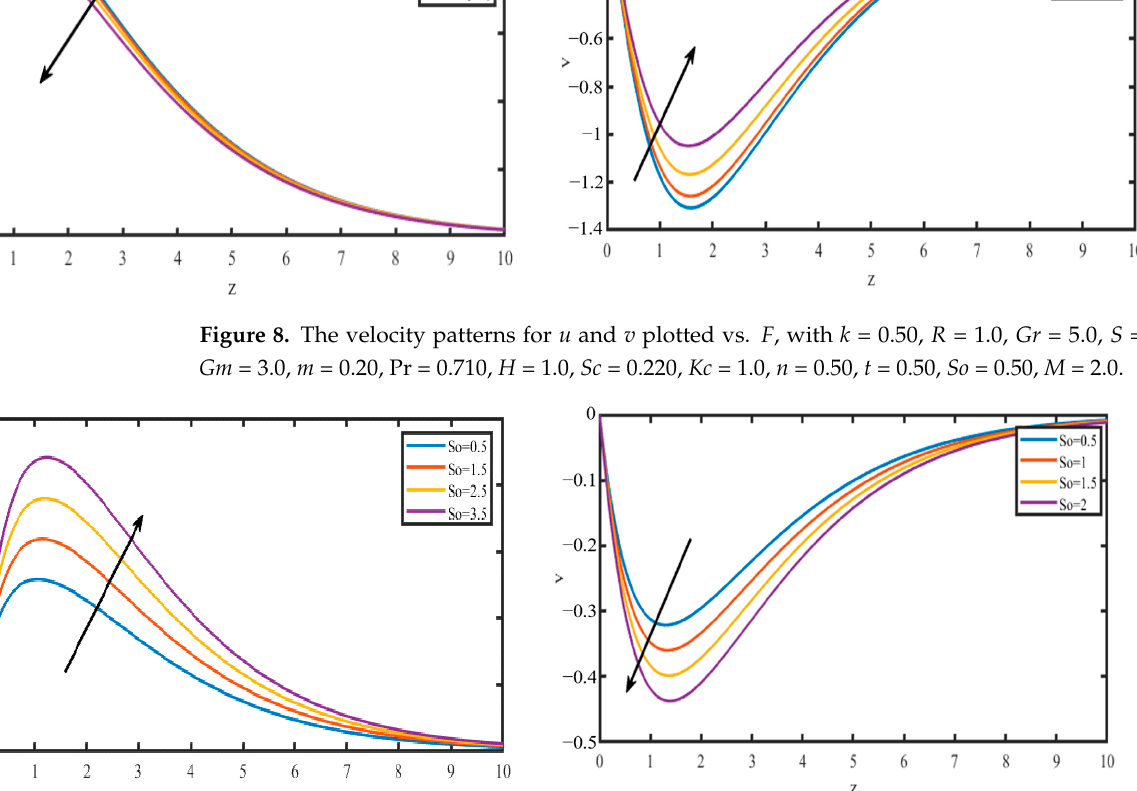
Figure 9. The velocity patterns for u and v plotted vs. So , with k = 0.50, R = 1.0, Gr = 5.0, S = 1.0, Gm = 3.0, m = 0.20, Pr = 0.710, H = 1.0, Sc = 0.220, Kc = 1.0, n = 0.50, t = 0.50, M = 2.0, F =